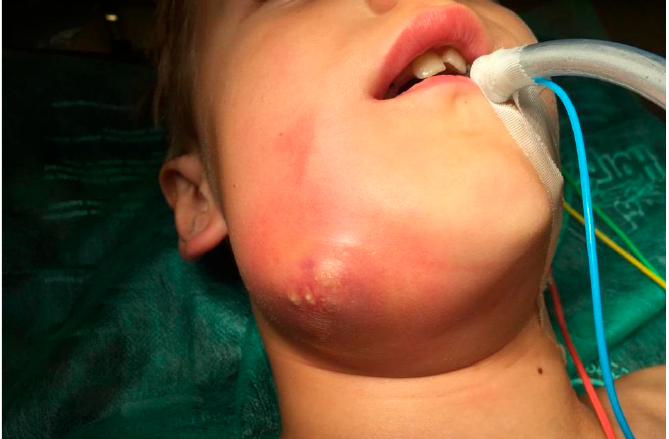
Figure 5. 8-year-old patient with facial phlegmon on the right side.